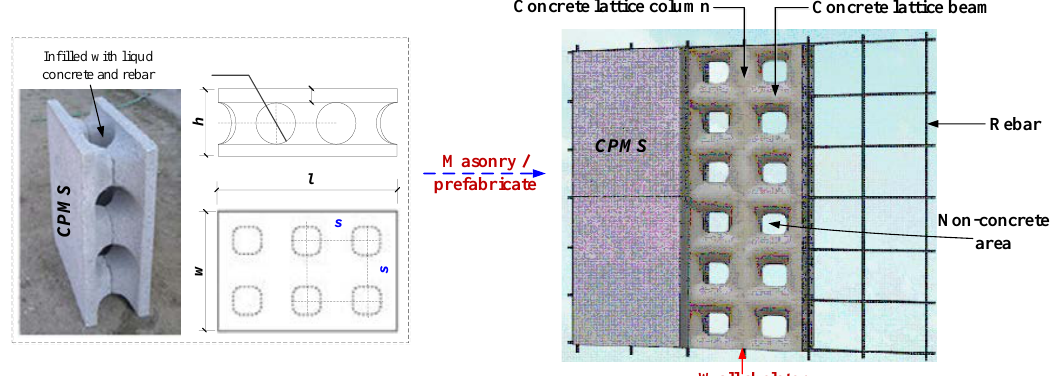
Figure 1. CPMS grid concrete wall.